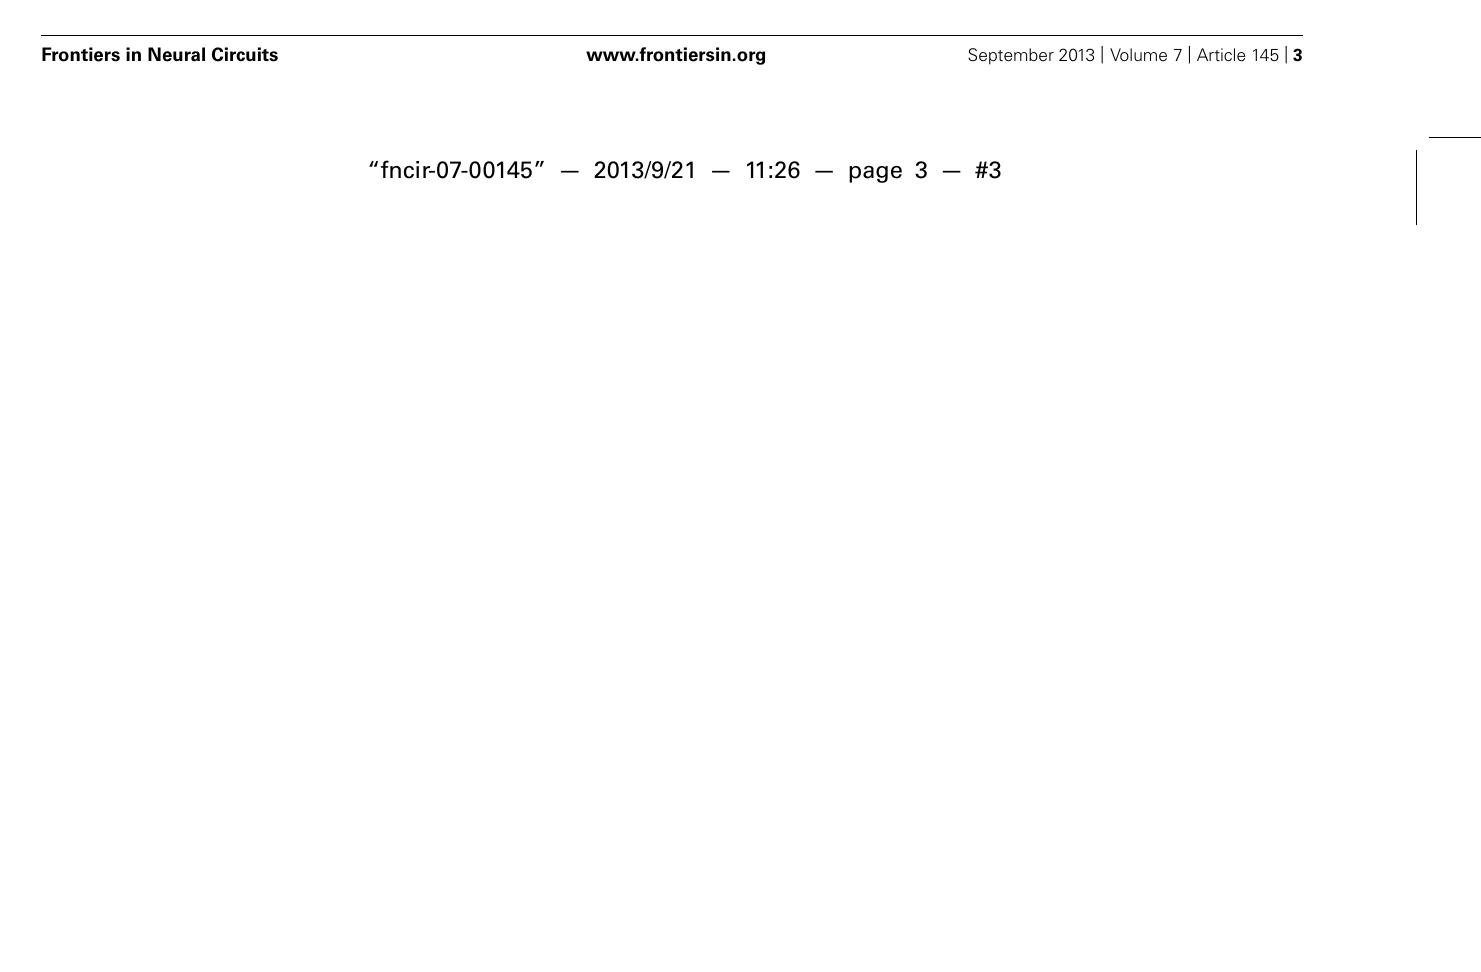
sensitivity of OKR. Light-adapted mutants ( n = 12) were not different from heterozygotes ( n = 10) or WT ( n = 13). Bars: SEM. (C) Changes in OKR strength of WT fish (7 dpf) following pharmacological reduction or elevation of GR activity. Overnight treatment with RU-486 (RU, 10 μ M) diminished the number of saccades to a constant stimulus, whereas overnight dexamethasone (Dex, 100 μ M) barely increased them. Control treatment was 1% DMSO. Bars: SEM. Asterisk: significant difference ( p <